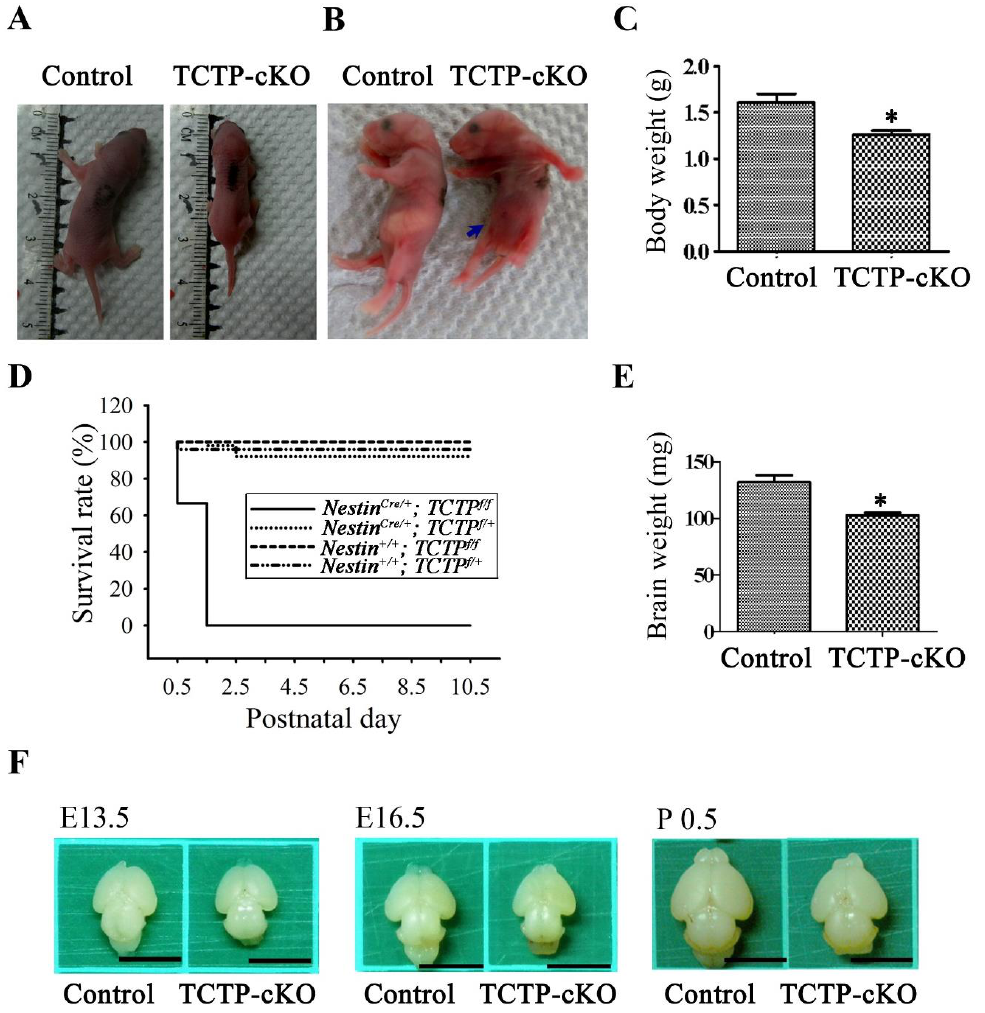
Figure 3. Phenotypes and survival rates of TCTP-cKO mice. ( A ) Body size of control and TCTP-cKO mice at P0.5. ( B ) Milk in stomachs of control and cKO mice at P0.5. ( C ) Body weight of control and cKO mice at P0.5 (data presented as mean ± SEM, * p < 0.05, Student’s t test, n = 3 per group). ( D ) Survival rate of o ff spring from Nestin Cre /+ ; TCTP f /+ mice crossed with TCTP f / f mice during development from P0.5 to P10.5. ( E ) Brain weight of control and cKO mice at P0.5 (data presented as mean ± SEM, * p < 0.05, Student’s t test, n = 4 per group). ( F ) Morphology of brains from control and cKO mice at E13.5, E16.5, and P0.5. Scale bar: F, 0.5